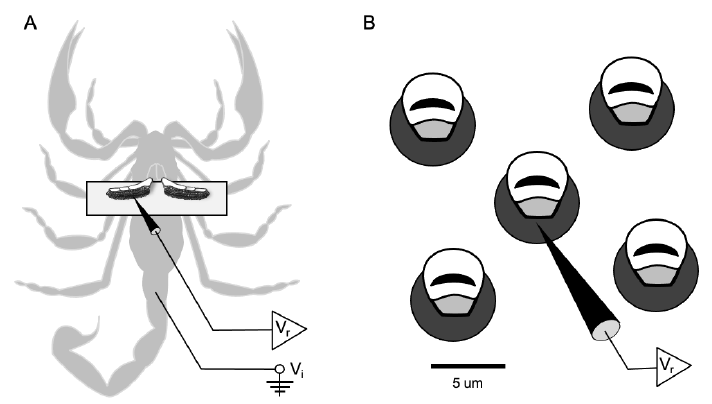
Figure 1. Extracellular electrophysiological recording from individual peg sensilla. ( A ) The scorpion is shown ventral side up with the pectines secured atop a coverslip. Note the recording electrode (V r ) inserted into the left pecten and the indifferent electrode (V i ) inserted in the tail. ( B ) A close up diagram of individual peg sensilla shows the recording electrode inserted through the base of a single